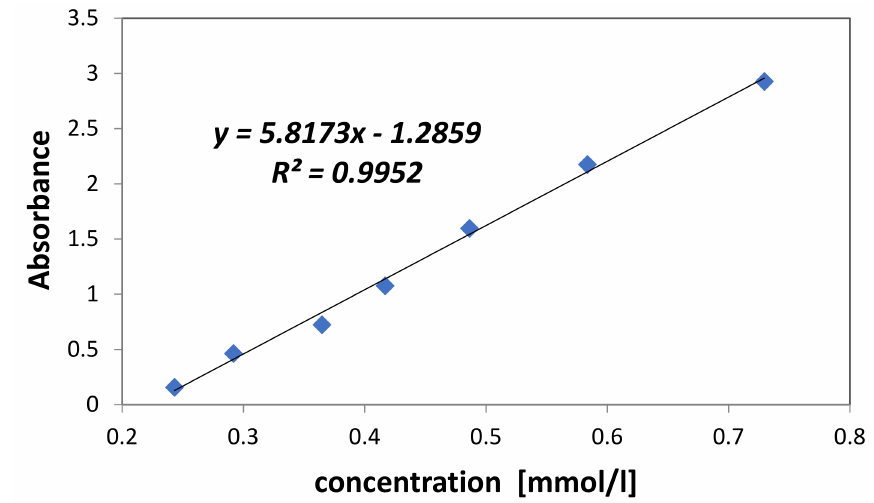
Figure 9. A standard curve for vitamin B6 (Pyridoxal